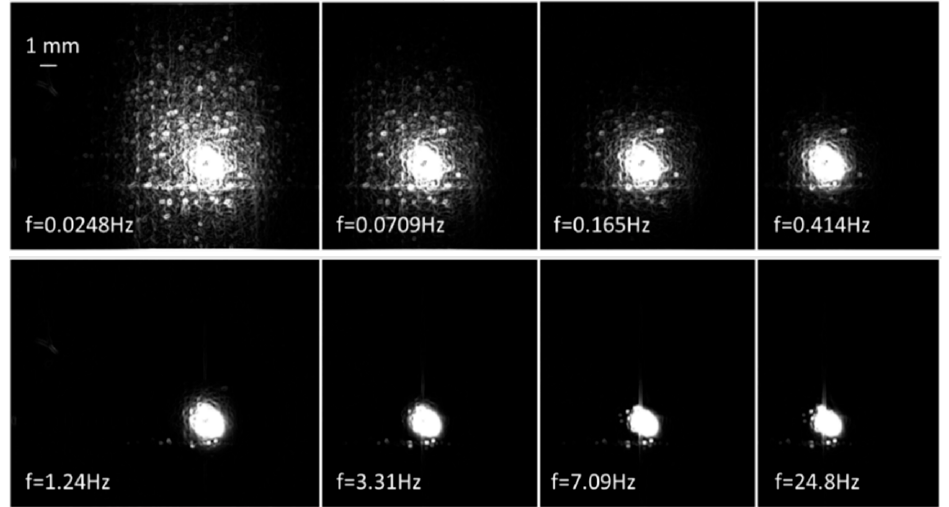
Figure 4. LLT amplitude images of sample A at di ff erent modulation frequency. Thermal di ff usion length increases with decreasing modulation frequency, so that a larger area is covered. Total field of view is 15 × 18 mm 2 .